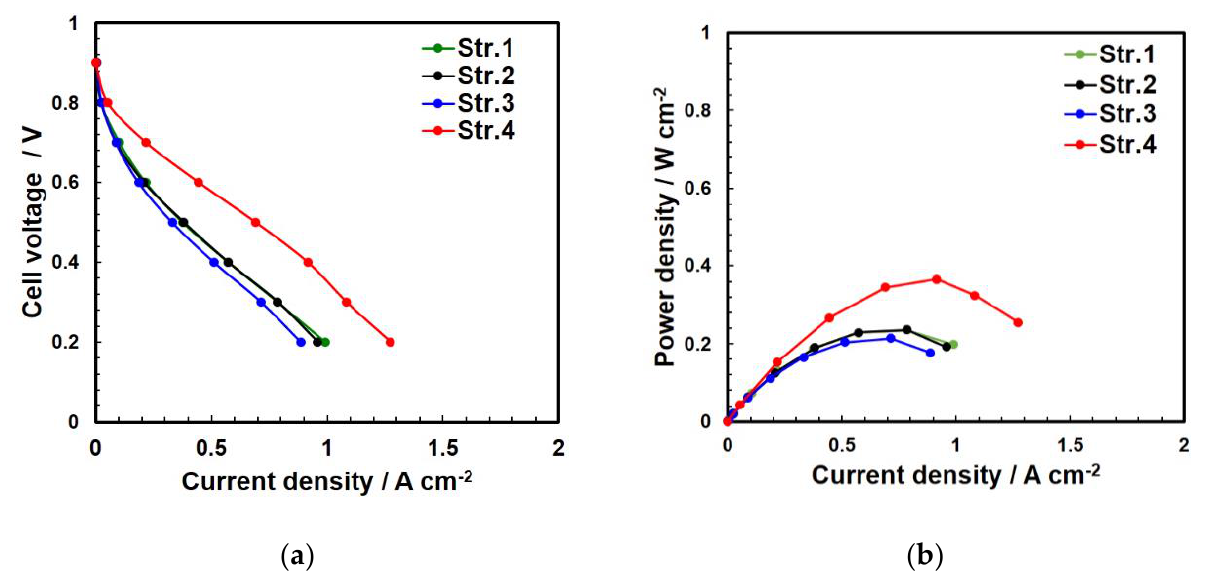
Figure 8. ( a ) Polarization curves and ( b ) power densities of the four samples at 40% RH.